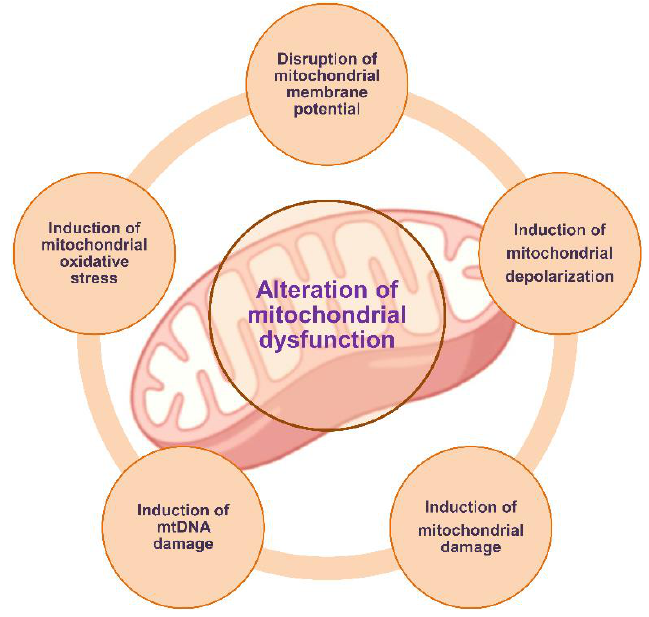
Figure 3. Role of mitochondria in response to micro- and nanoplastics toxicity.